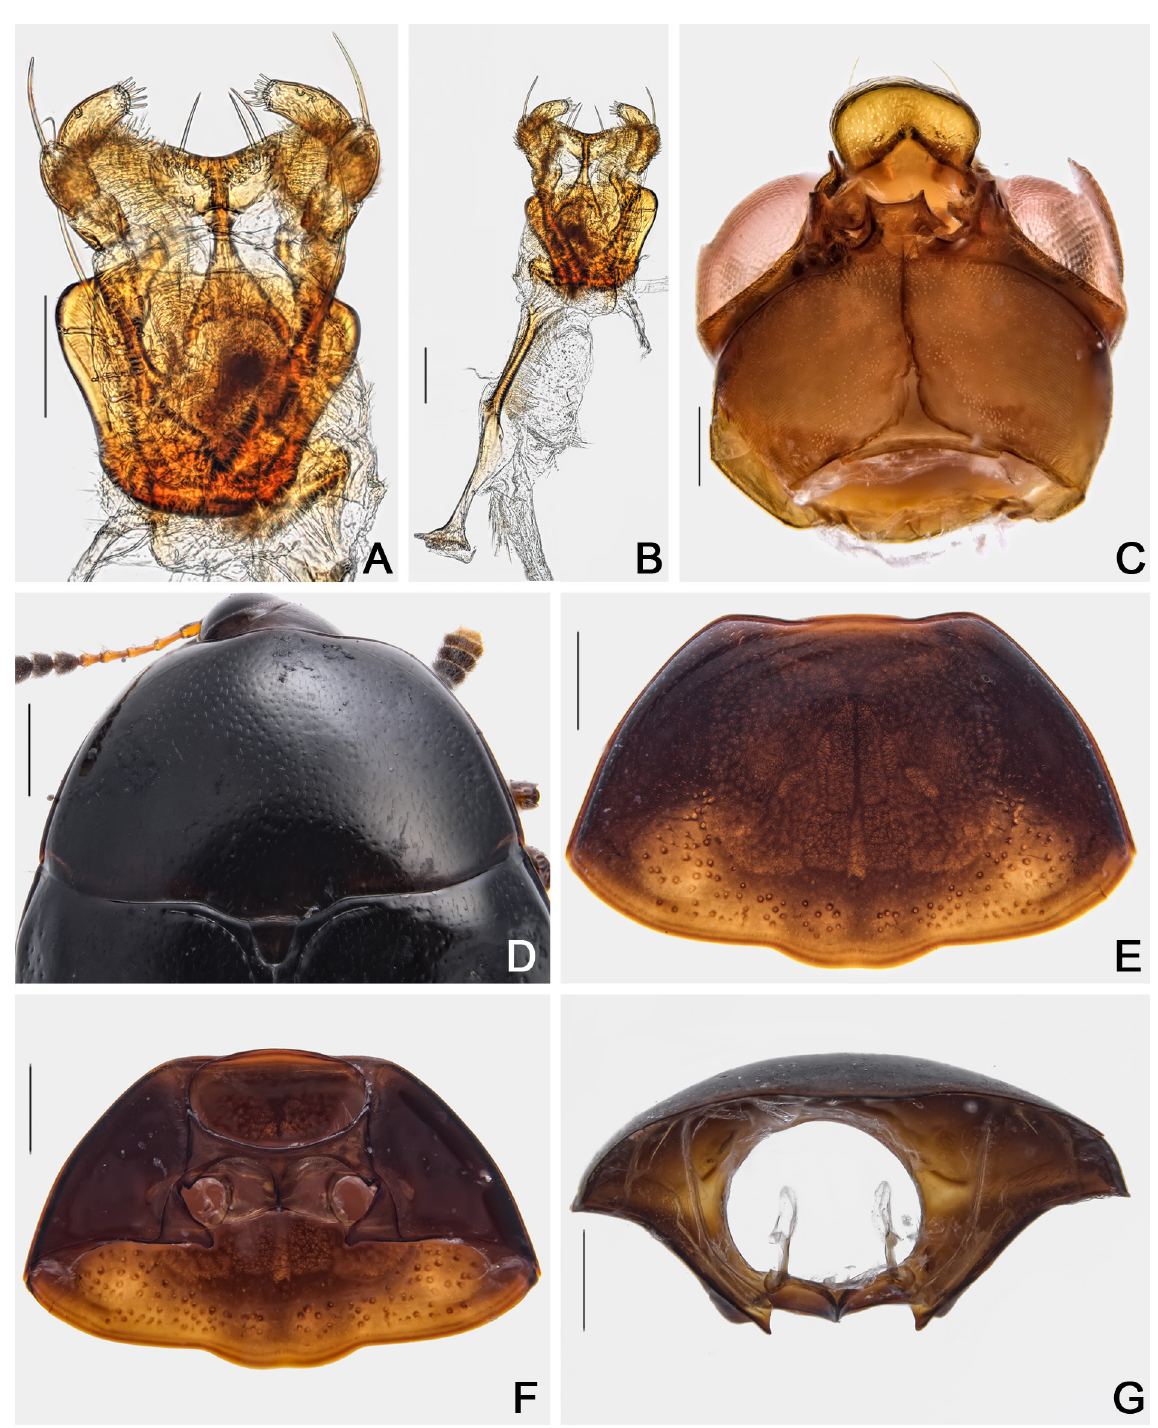
Fig. 58. Cyparium oberthueri Pic, 1956, ♂♂ (CELC). A . Labium. B . Hypopharynx. C . Head, ventral view. D–E . Pronotum, dorsal view. F–G . Prothorax. F . Ventral view. G . Inner view. Specimens collected at Mata da Biologia, Viçosa (MG, Brazil). Scale bars: A–B = 0.1 mm; C = 0.2 mm; D–G = 0.5